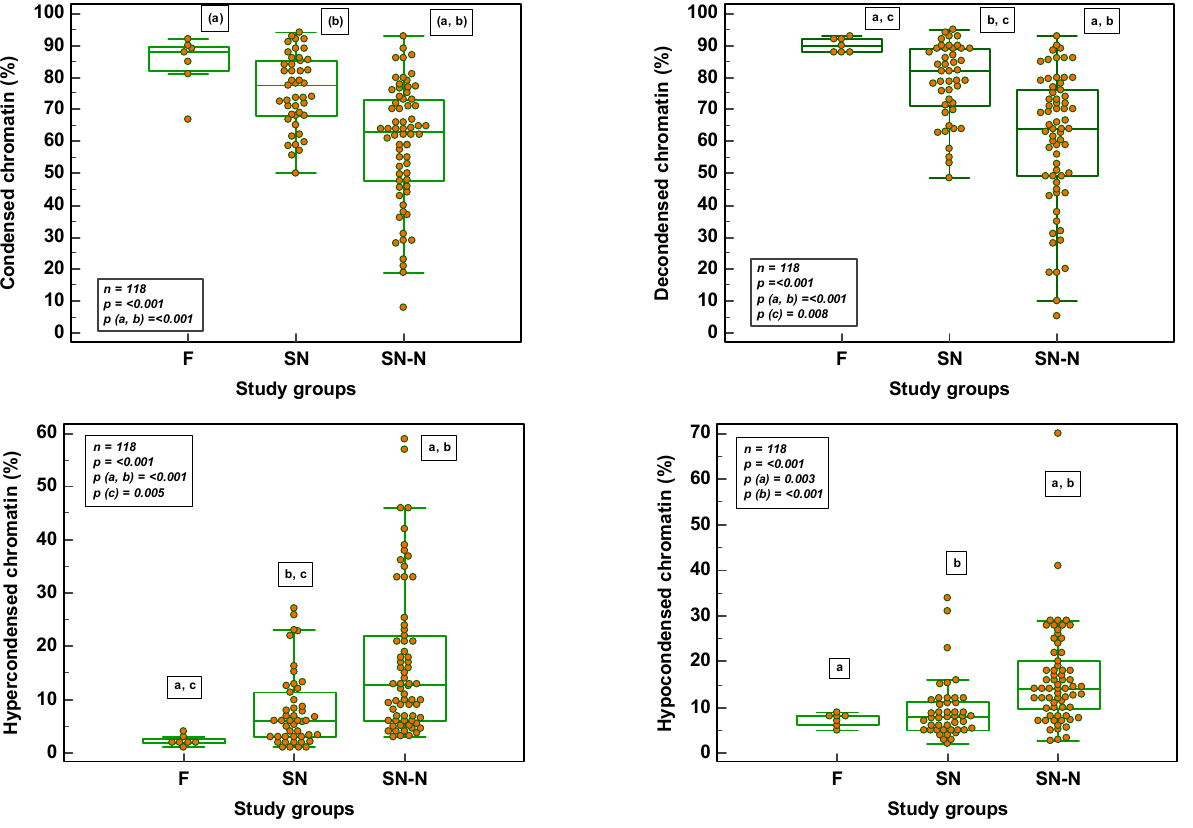
Figure 5. Chromatin parameters in the different study groups (F = fertile population; SN = subfertile population with normozoospermia; SN-N = subfertile non-normozoospermic population).